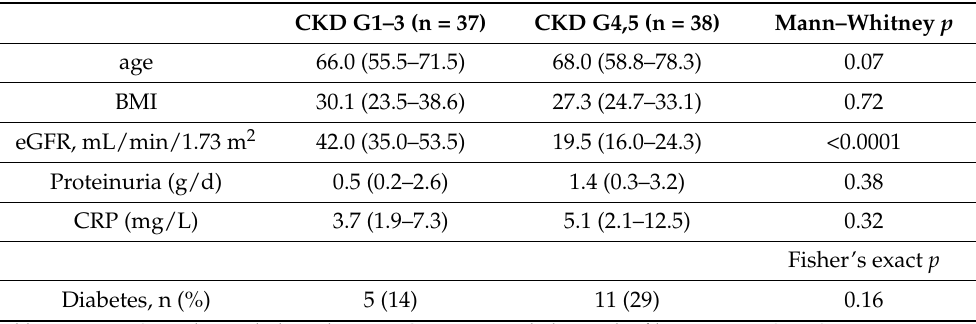
Table 4. Comparison of clinical parameters with potential relation to Nrf2 between mild to moderate kidney function impairment (G1–3) and severe kidney function impairment (G4,5) CKD. Values are given as median (25–75% percentile) or number (percentage). CKD G1–3 (n =